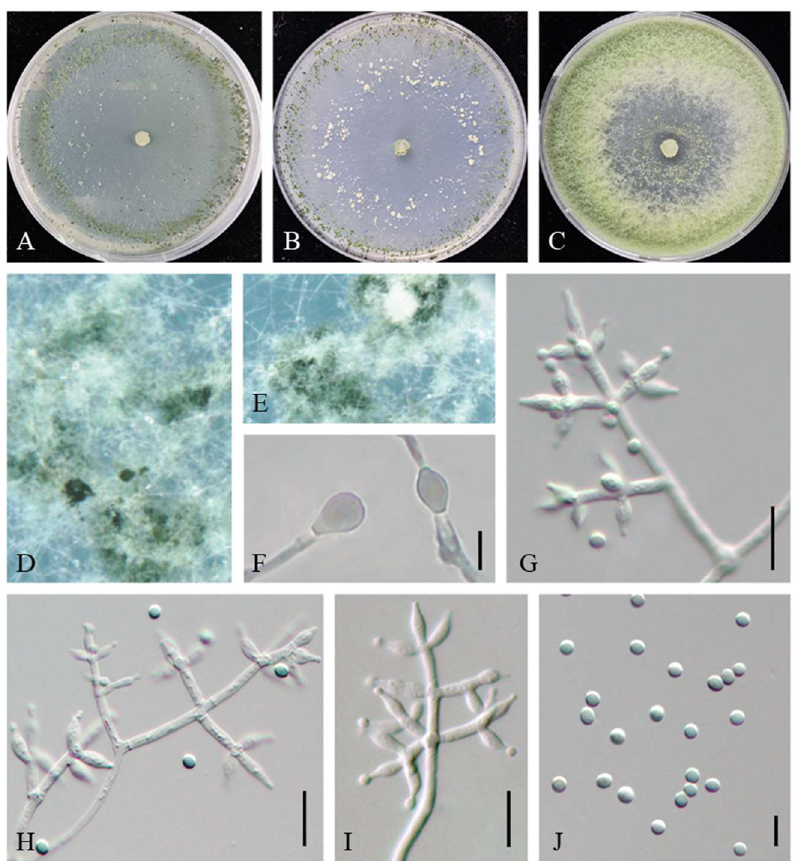
Figure 4. Trichoderma pholiotae (JZBQH12). Cultures at 25 ◦ C after 7 days on ( A ) CMD, ( B ) SNA, and ( C ) PDA; ( D , E ) conidiation pustules on SNA after 7 days; ( F ) chlamydospores; ( G – I ) conidiophores and phialides; ( J ) conidia. Scale bars: ( F , J ) = 5 µm, ( G – I ) = 10 µm.